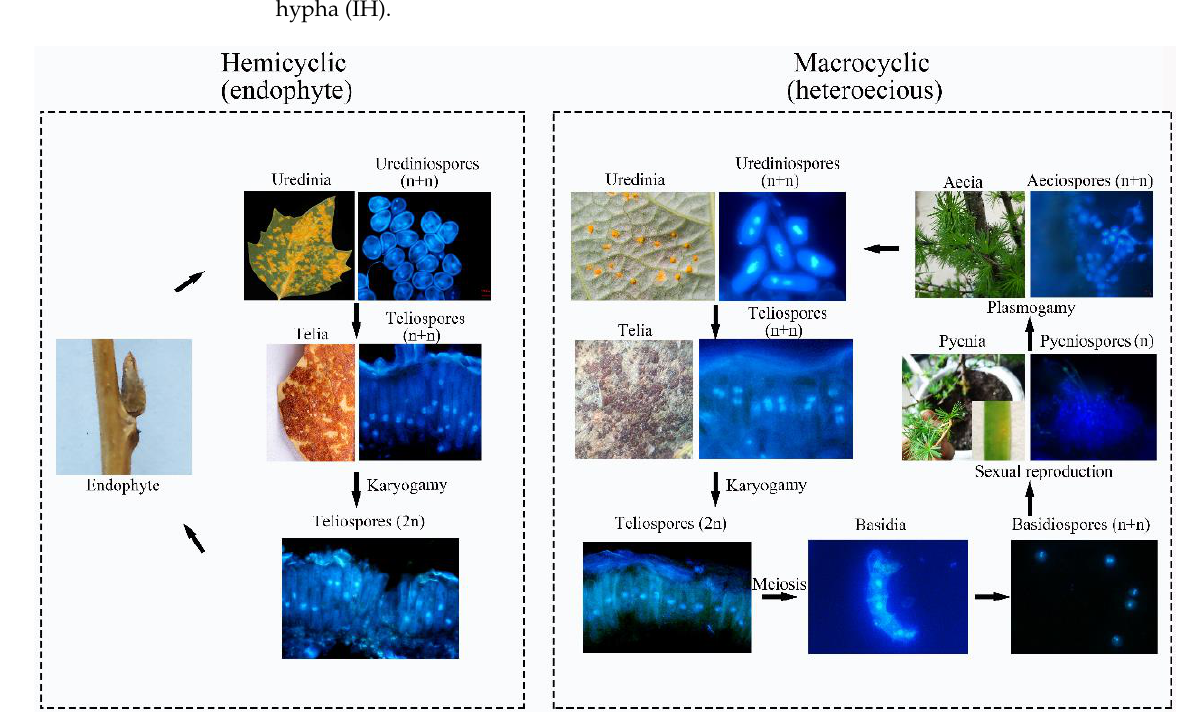
Figure 10. Lifecycle model of the macrocyclic rust and the hemicyclic rust.